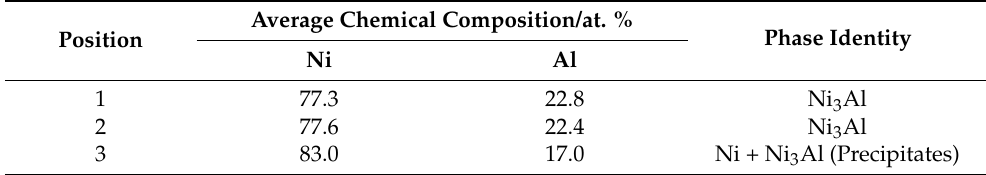
Table 2. Compositions of reacted Ni-Al system products determined by EDS in Figure